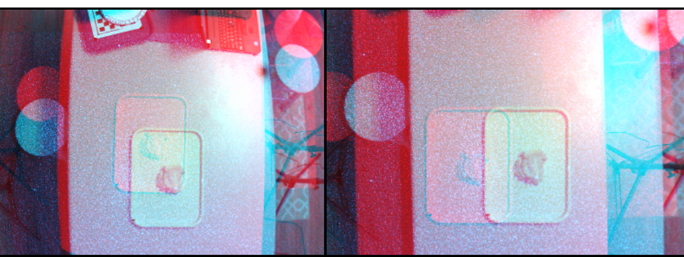
Figure 8. Stereo-image rectification: ( Left ) unrectified images (red-cyan composite view); ( Right ) rectified images (red-cyan composite view).